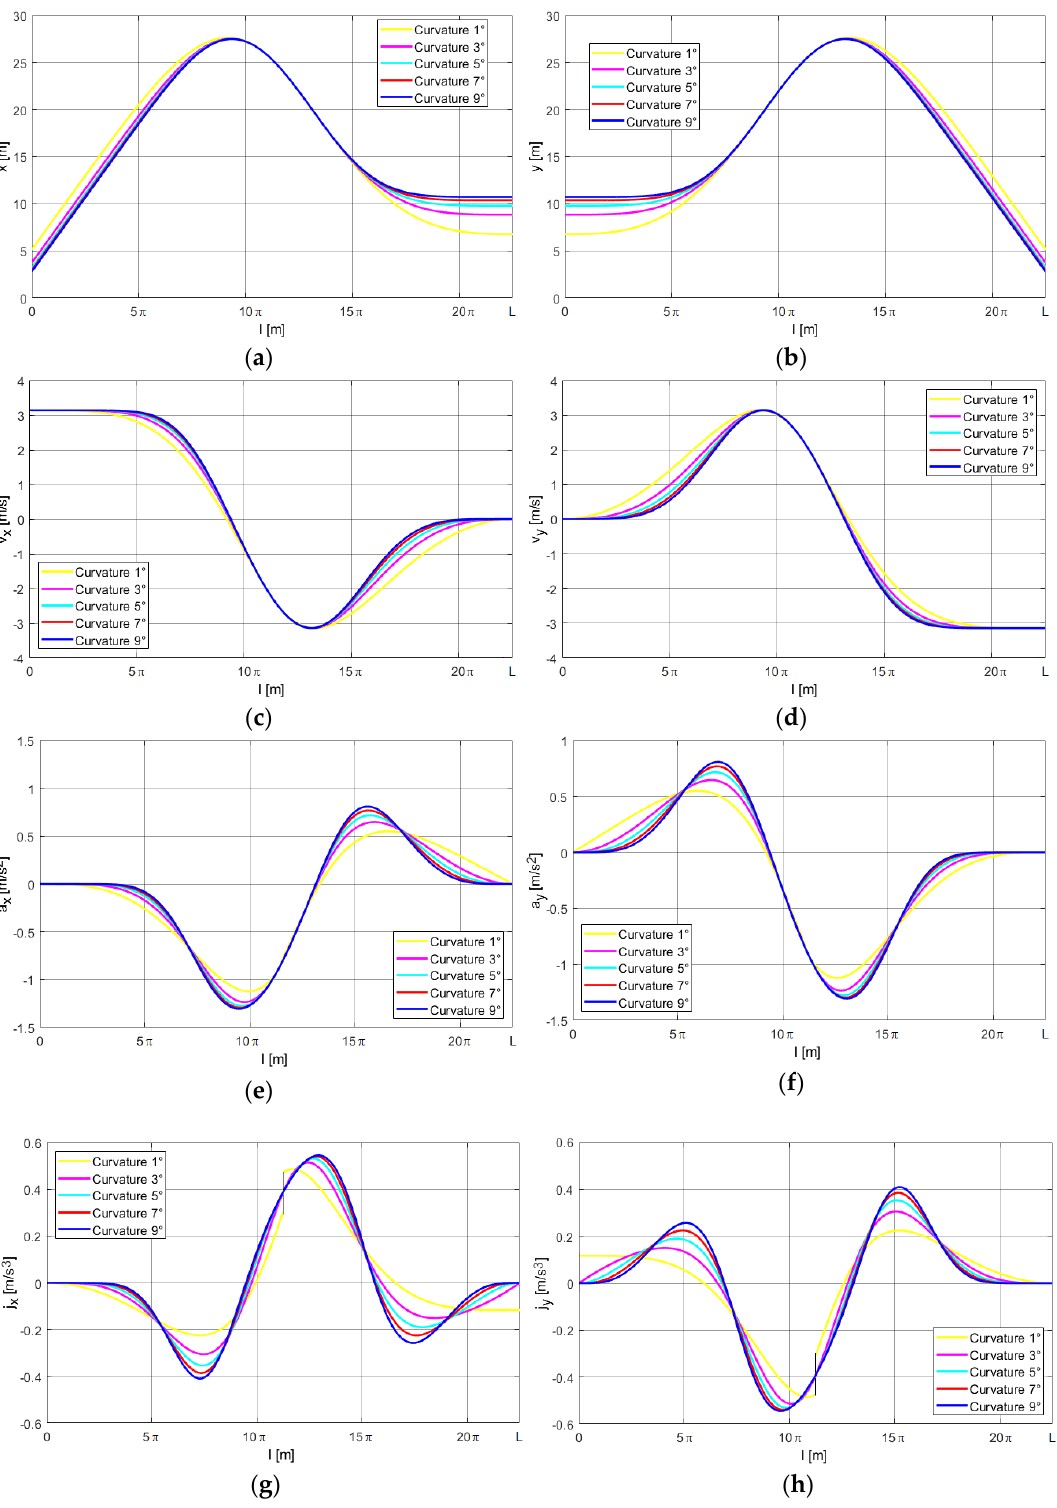
Figure 11. The course of kinematic quantity components for the RHO trajectory: ( a ) displacement along the axis x; ( b ) displacement along the axis y; ( c ) velocity along the axis x; ( d ) velocity along the axis y; ( e ) acceleration along the axis x; ( f ) acceleration along the axis y; ( g ) jerk along the axis x; ( h ) jerk along the axis y.